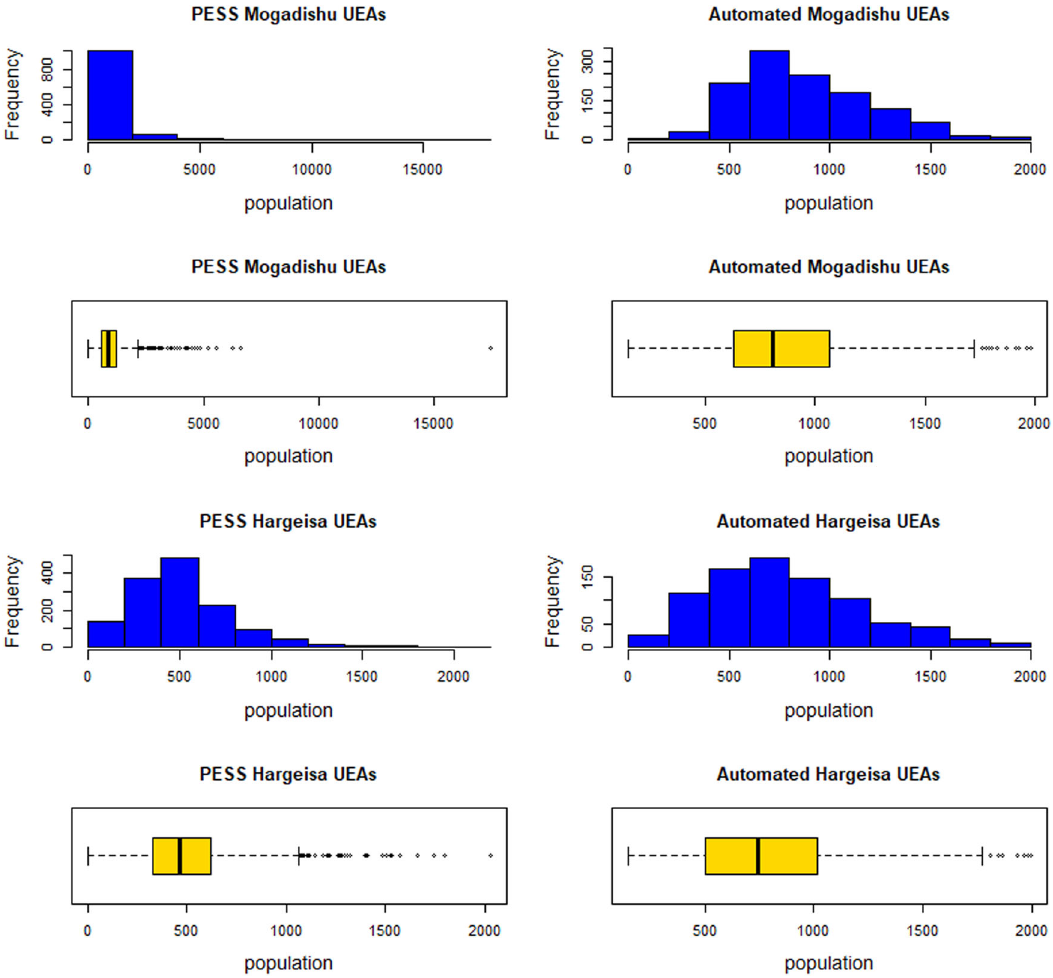
Fig. 7 Histogram distribution of population within urban PESS 2014 ’ s EAs and automated urban EAs in Hargeysa and Mogadishu, Somalia, based on high resolution gridded population estimates. For the comparison, we assume that the maximum population could be 2000 people per EA, but the preferred target is 1000 people per EA. The population size per PESS urban EA in Mogadishu ranges from 0 to 17,000 and area ranges from 5 m 2 to 7 km 2 . In both cities, the population size in the automated EAs ranged from 150 to 2000 and the area constraints ranged from 2000m 2 to 4 km 2